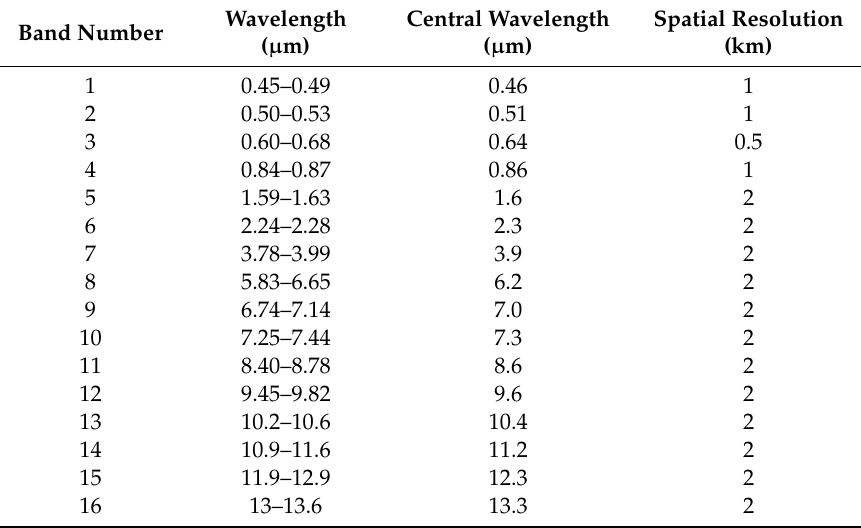
Table 1. Himawari–8 Advanced Himawari Imager (AHI)